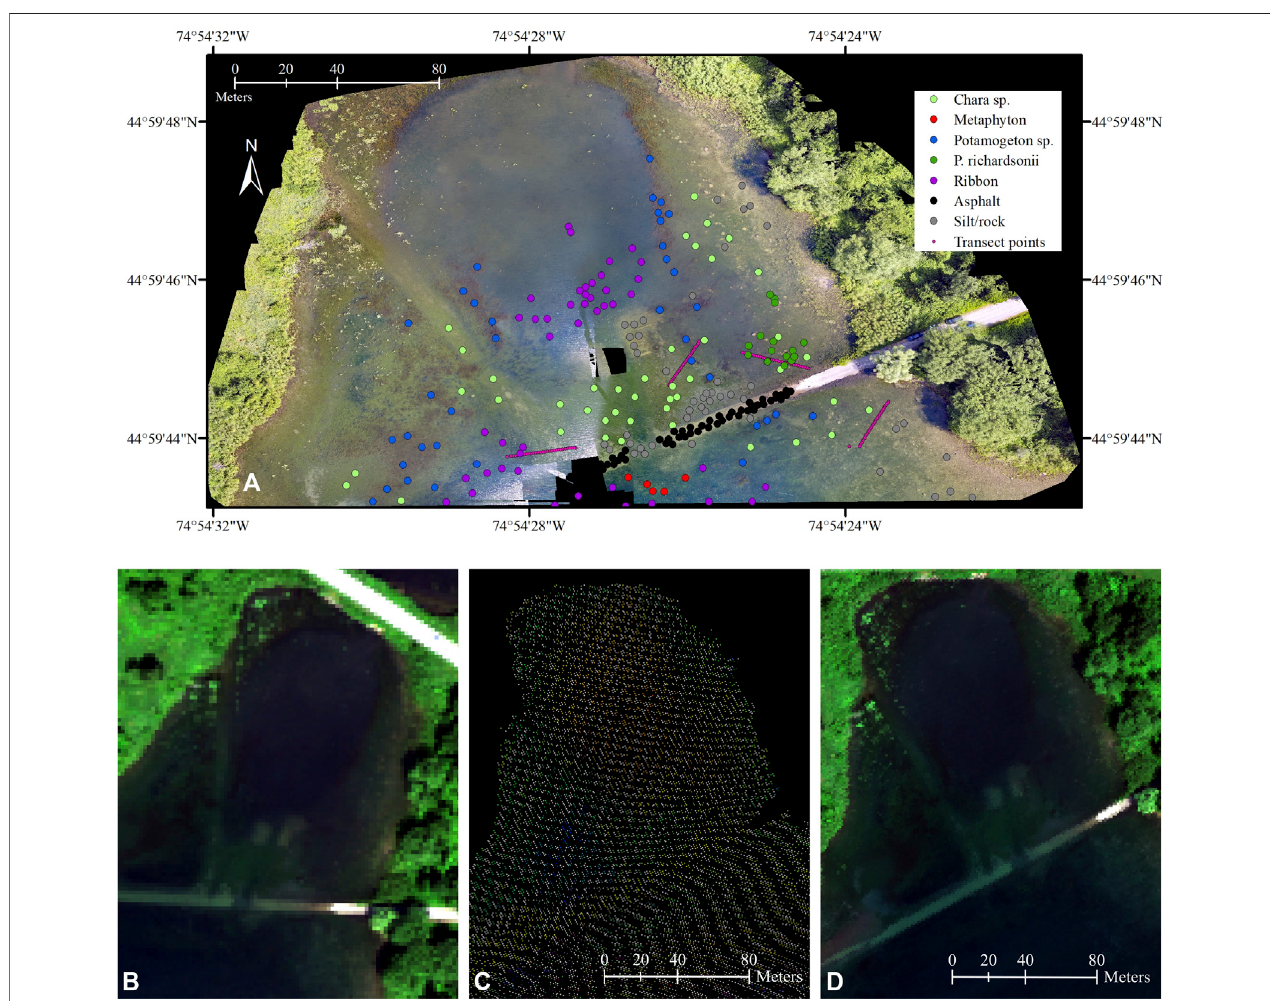
FIGURE 8 | CASI imagery used in this work at various processing stages and the input points used in target detection and validation. (A) RPAS orthomosaic showing points of each class chosen through visual interpretation and the locations of the transect points. (B) Atmospherically compensated CASI image (red (cid:1) 687.5 nm, green (cid:1) 548.7, blue (cid:1) 500.3 nm, optimized linear stretch applied on extent) before geocorrection. (C) DII-transformed CASI image following rasterization of the directly georeferenced point cloud without resampling (red (cid:1) 682.7 and 701.8 nm DII, green (cid:1) 553.5 and 563.1 nm DII, blue (cid:1) 424.3 and 438.7 nm DII, linear stretch on extent applied). Each pixel is a 25 cm by 25 cm visualization of the set of DIIs centered at the coordinates calculated to be where the signal originated from. (D) Conventionally geocorrected CASI imagery after atmospheric compensation, for reference.